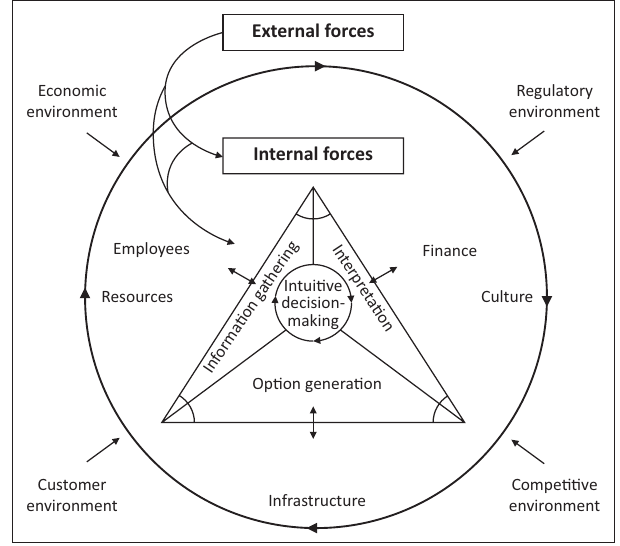
FIGURE 1: Integrated model of the strategic decision-making process in small and micro enterprises in South